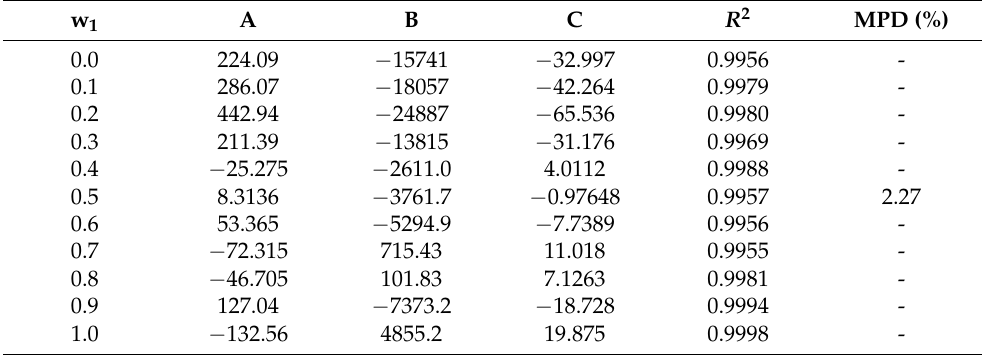
Table 2. Results for the modified “Apelblat model” for CNZ (3) in various {TP (1) + water (2)}